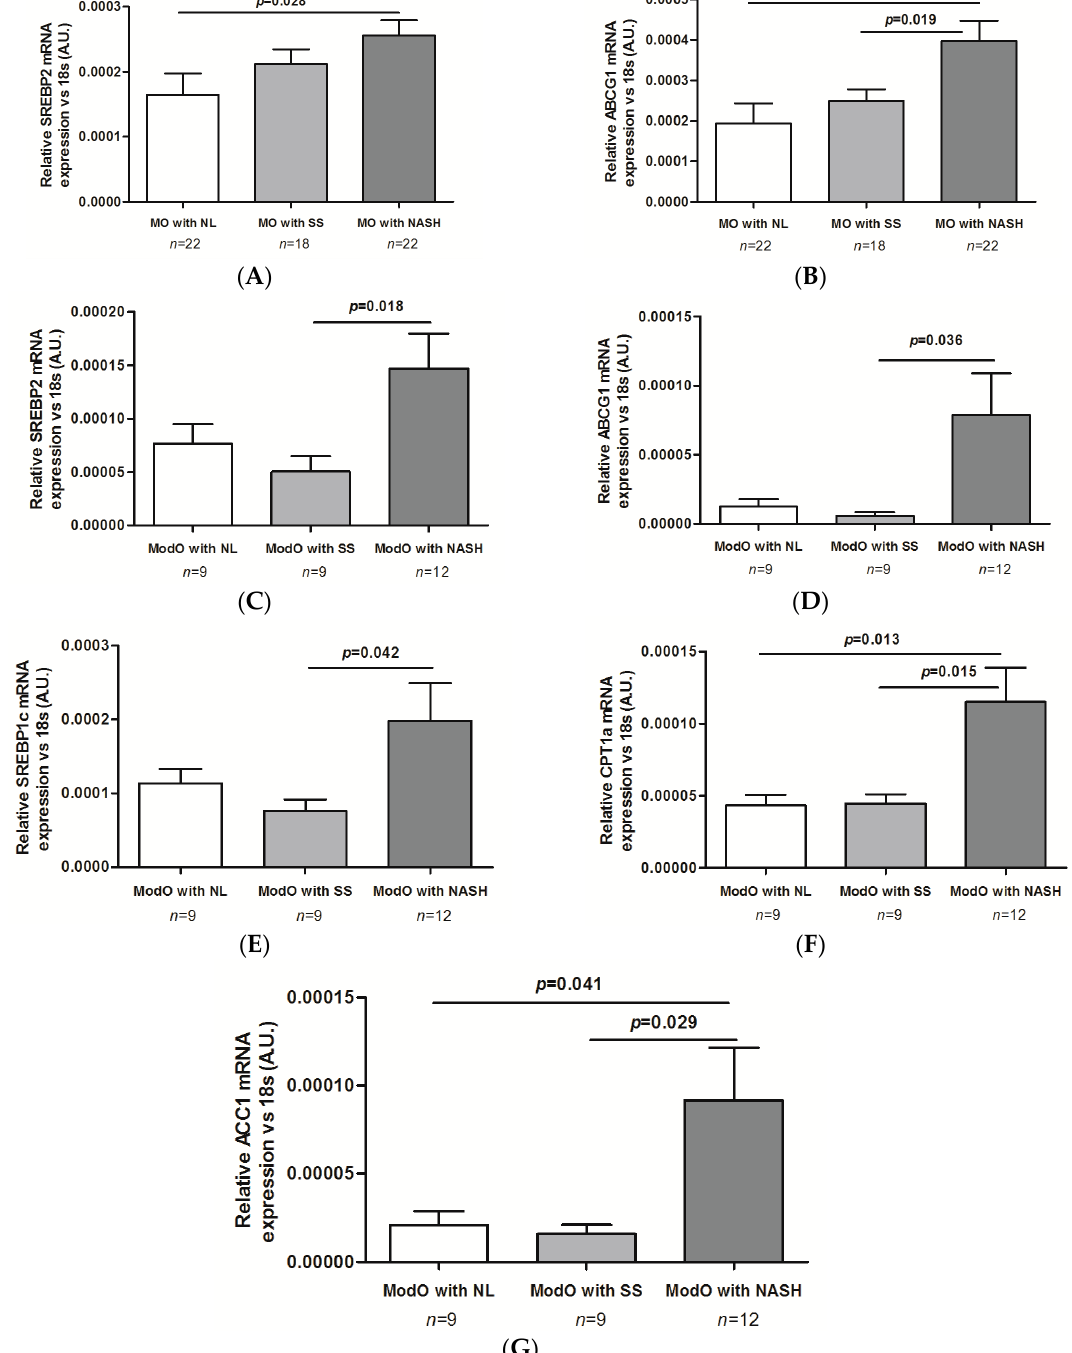
Figure 3. Liver expression of SREBP2 ( A ) and ABCG1 ( B ) in morbidly obese patients according to liver histology and liver expression of genes involved in lipoprotein secretion ( C – E ); lipogenesis ( F ) and lipid oxidation ( G ) of moderately obese patients according to liver histology. Morbidly obese (MO) patients with normal liver (NL); MO patients with simple steatosis (SS); MO patients with nonalcoholic steatohepatitis (NASH); Moderately obese (ModO) patients with NL; ModO patients with SS; ModO patients with NASH; AU, arbitrary units. Differences between groups were calculated using one-way ANOVA. Results are shown as the mean ± SEM. p < 0.05 is considered statistically significant.